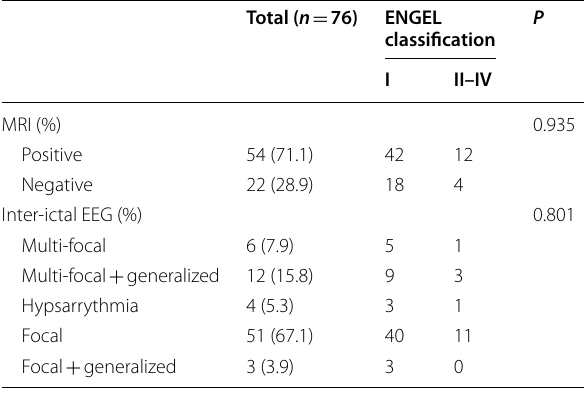
Table 3 Presurgical radiological data and scalp